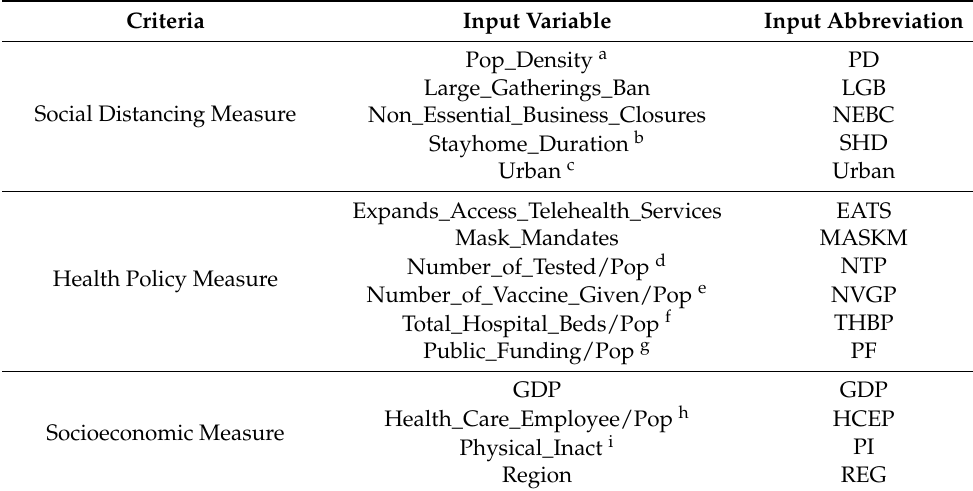
Table 2. Three Input Criteria and Input Abbreviation used in the ML